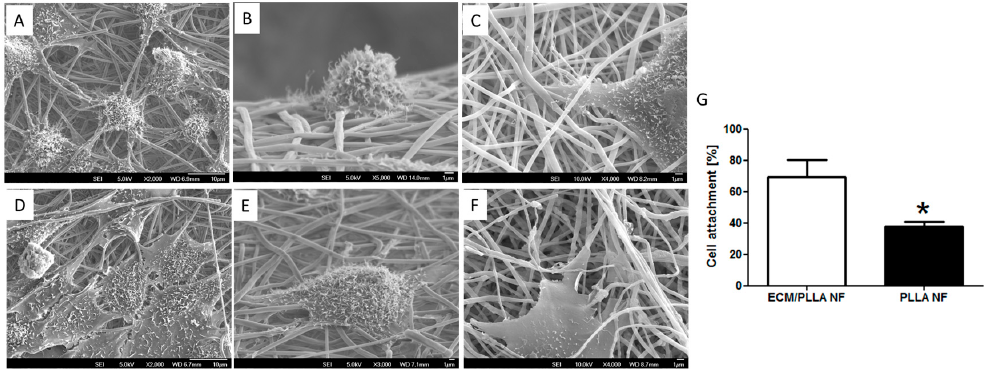
Figure 2. mBMSC adhered on PLLA electrospun nanofibers before and after ECM decoration: ( A ) Overview of mBMSCs on PLLA NF; ( B ) Single cell attached on PLLA NF; ( C ) Highlight of mBMSCs attached to PLLA nanofibers; ( D ) Overview of mBMSCs on ECM/PLLA NF; ( E ) Single cell attached on ECM/PLLA NF; ( F ) Highlight of mBMSCs attached to ECM/PLLA nanofibers. ( G ) mBMSC attachment on two scaffolds after 2 h; * indicates significant difference at p < 0.05.